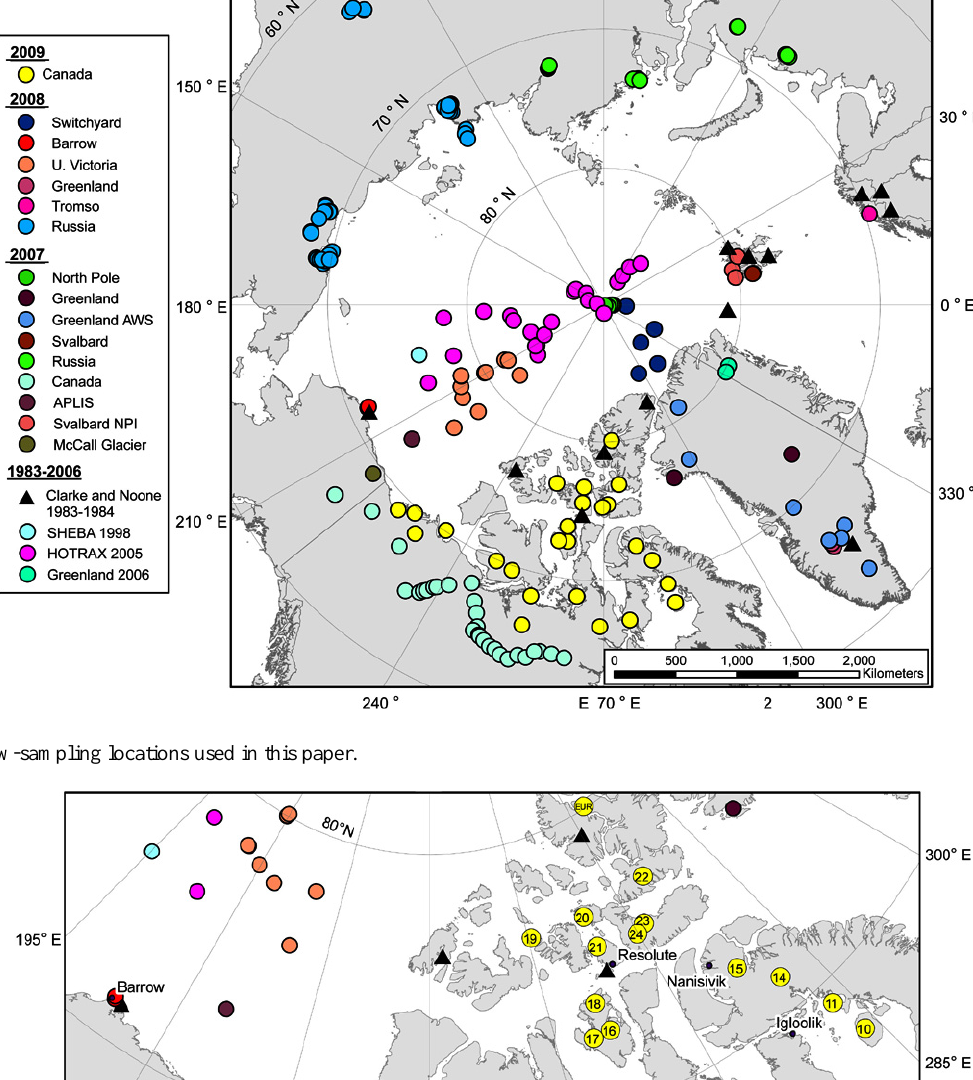
Fig. 2. All snow-sampling locations used in this paper.